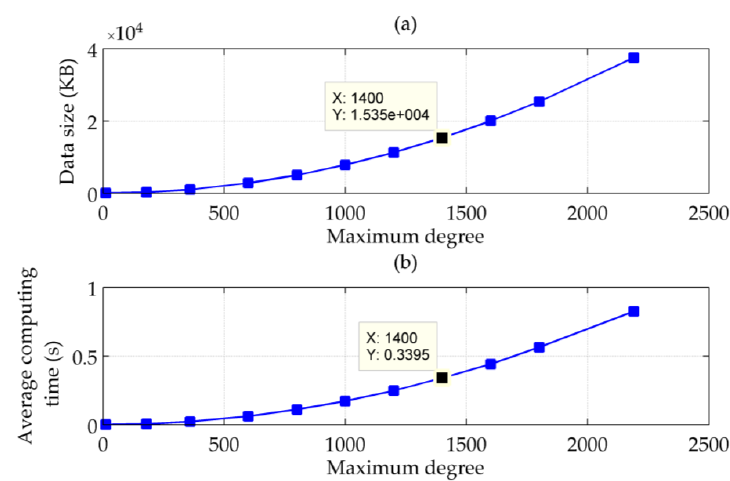
Figure 8. ( a ) Sizes of spherical harmonic coefficient files; and ( b ) Average computing time vs. maximum degree of the used spherical harmonic model.